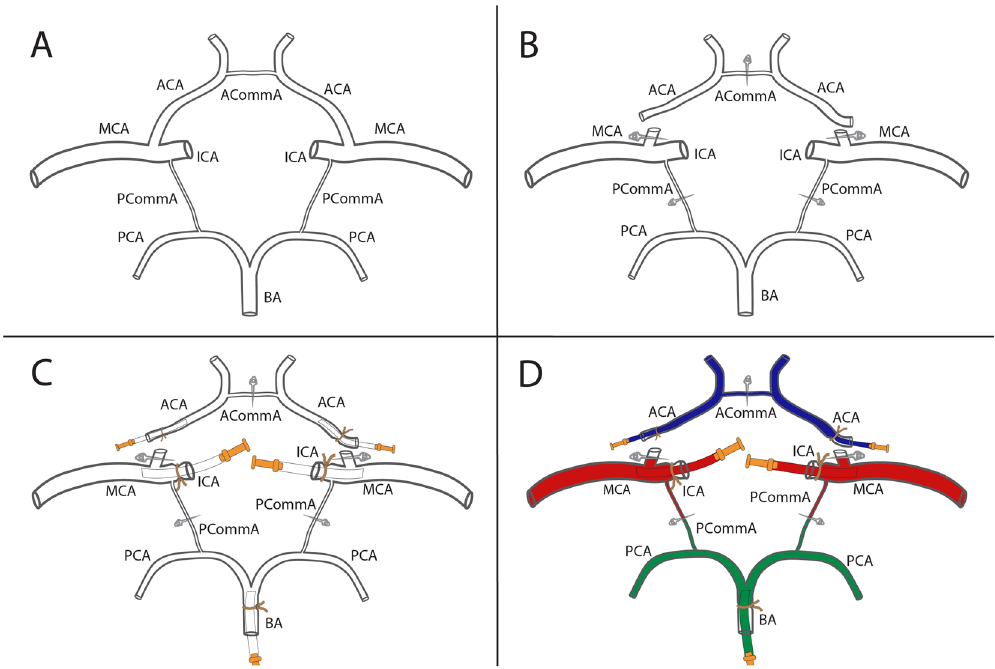
Figure 1. Catheterization of the cerebral arterial circle. ( A ): Cerebral arterial circle before catheterization. ( B ): The anterior and posterior communicating arteries were clipped. The anterior cerebral arteries were proximally sectioned. ( C ): Catheters were inserted and ligated in the corresponding arteries. ( D ): The cerebral arterial circle after arteries were flushed with isotonic saline and injected with colored gelatin solutions. We used blue for injection of the anterior, red for the middle, and green for the posterior cerebral arteries. ACA anterior cerebral artery, ACommA anterior communicating artery, BA basilar artery, ICA internal carotid artery, MCA middle cerebral artery, PCA posterior cerebral artery, PCommA posterior communicating